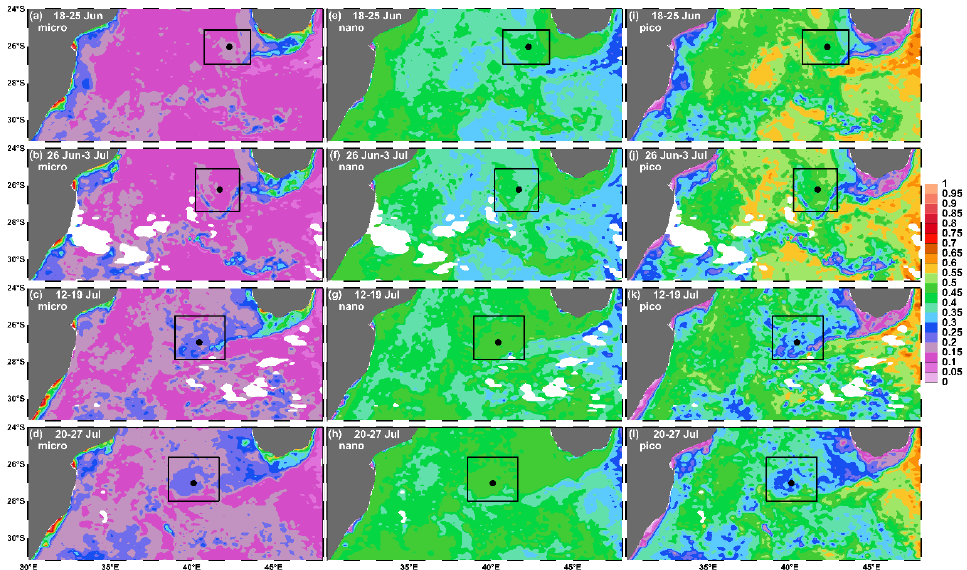
Figure 5. Fractional contribution of ( a – d ) micro-, ( e – h ) nano-, and ( i – l ) picophytoplankton to MODIS Aqua chlorophyll a for 18 June to 27 July 2013 over the Mozambique Basin. Black boxes highlight the location of the cyclonic eddy and black dots indicate the centre of the eddy. White areas indicate missing data due to cloud cover.